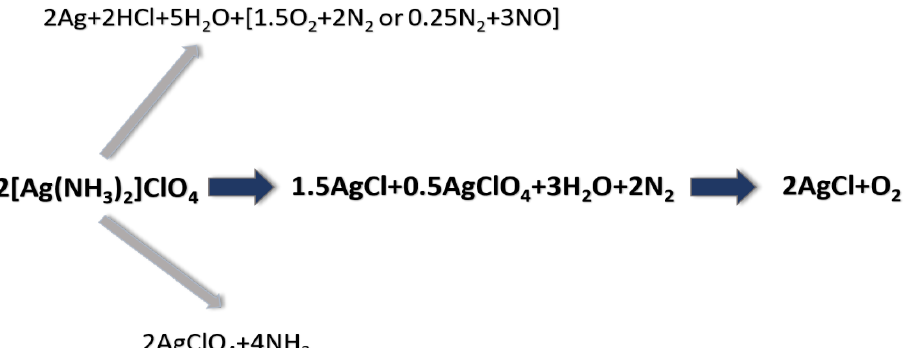
Figure 9. The presumed decomposition reactions of compound 1. |